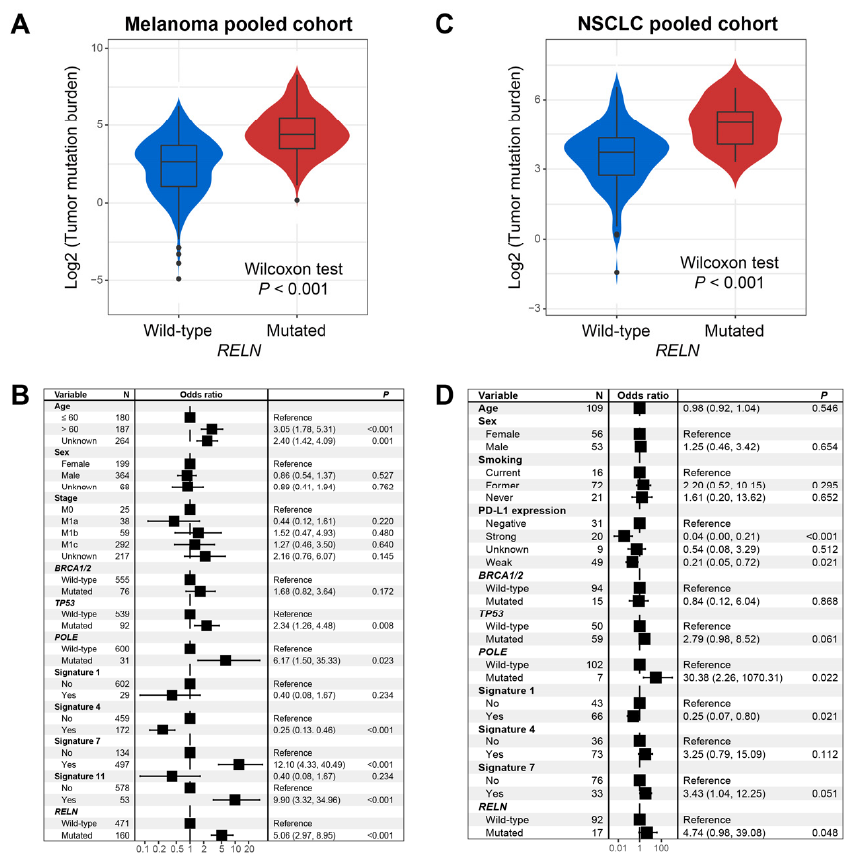
Figure 4. Association of RELN mutations with TMB in melanoma and NSCLC. ( A ) Univariate analysis between RELN mutations and TMB in melanoma. ( B ) Multivariable logistic analysis of RELN mutations was achieved with multiple confounding factors adjusted. ( C ) Univariate analysis between RELN mutations and TMB in NSCLC. ( D ) Multivariable logistic analysis of RELN mutations was achieved with multiple confounding factors controlled to acquire a real association.